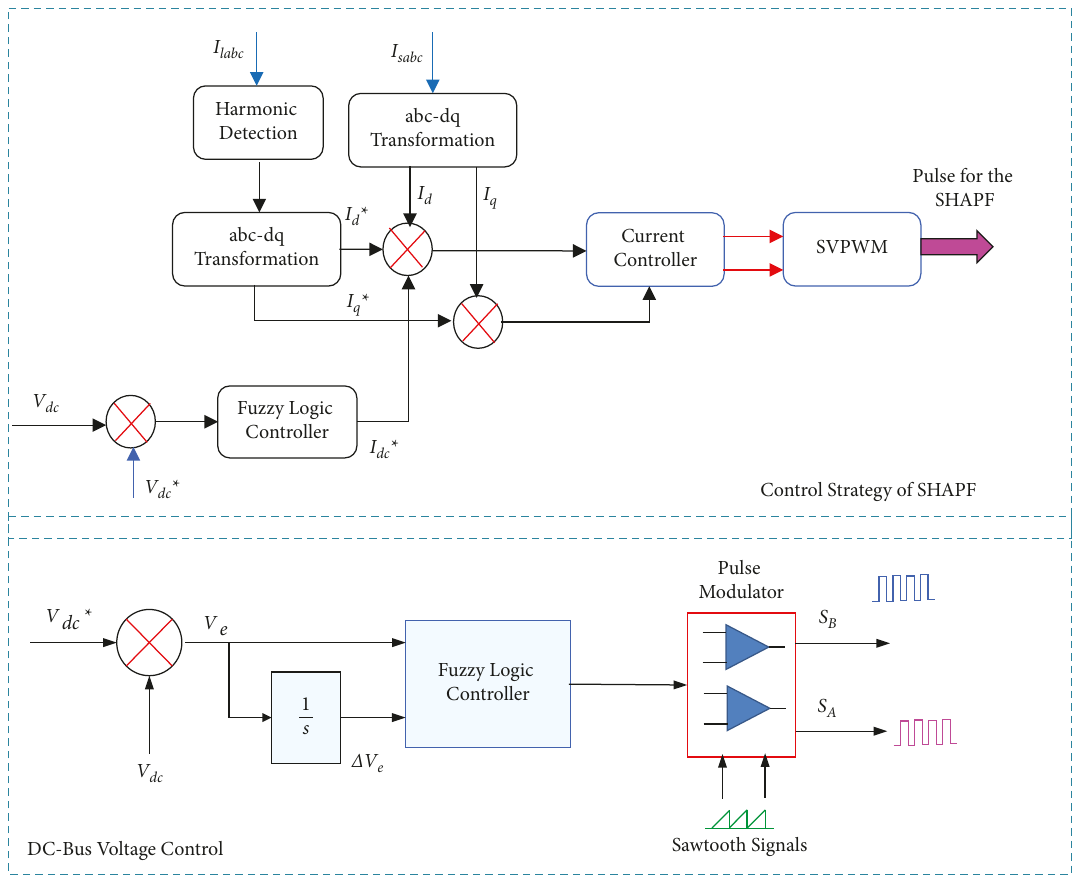
Figure 13: Control strategy of the proposed MTIIFC boost converter and